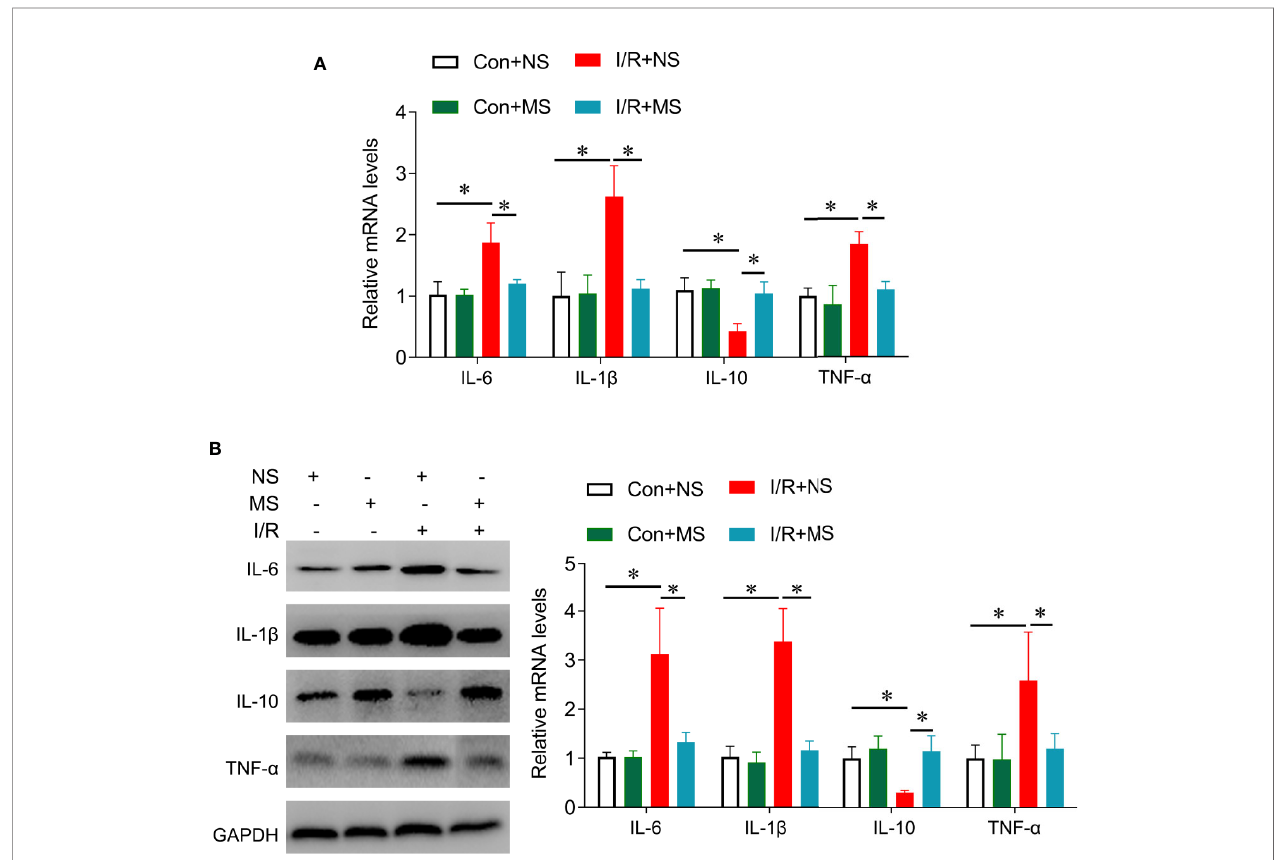
FIGURE 4 | The effects of Malva sylvestris L. on in fl ammatory genes in I/R rat model. (A) qPCR was performed to determine the expression of IL-6, IL-1 b , IL-10, and TNF- a in the infarcted heart tissues from I/R rat with or without MS pre-treatment. (B) Western blot was performed to determine the expression of IL-6, IL-1 b , IL-10, and TNF- a in the infarcted heart tissues from I/R rat with or without MS pre-treatment. *p < 0.05. MS, Malva sylvestris L.; NS, normal saline; I/R,